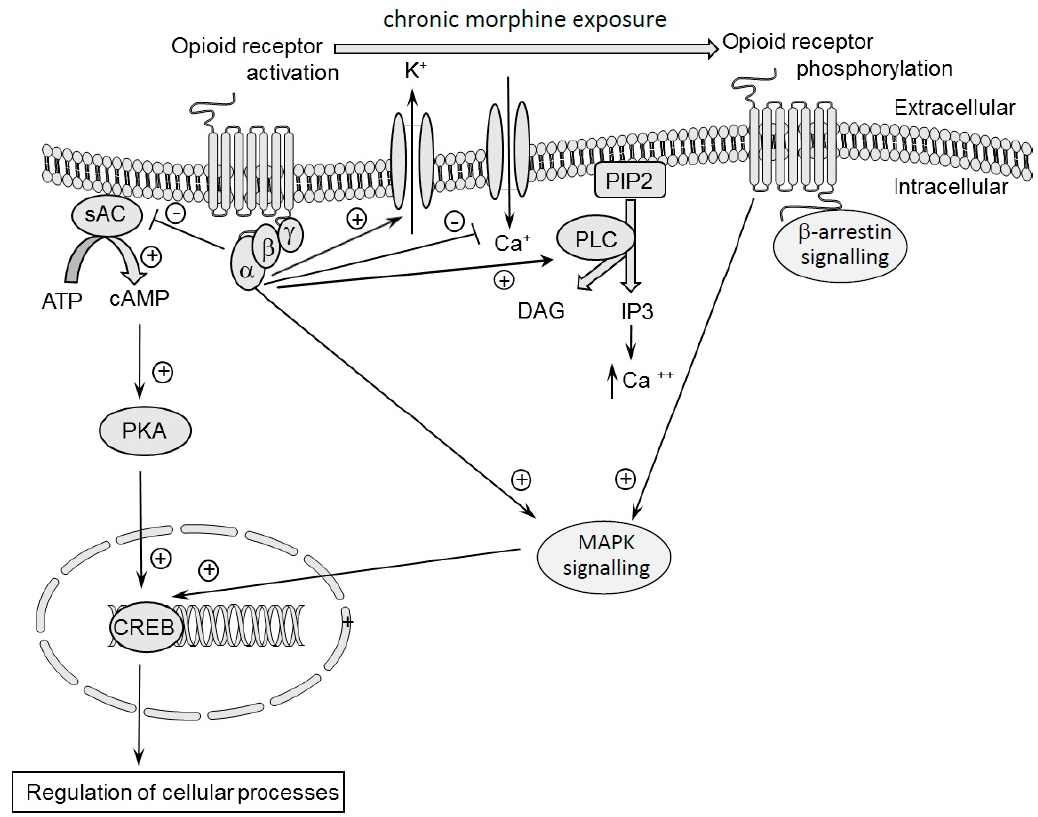
Figure 1. Molecular mechanisms of morphine action. A binding of ligand with an opioid receptor activates Go or Gi protein. G protein is composed of three subunits: α , β and γ . The ligand binding results in opioid receptor activation by GTP binding to the α subunit. The α -GTP complex dissociates from the dimer βγ -subunits. Both complexes: α -GTP and dimer βγ , participate in intracellular signal transduction. This leads to an inhibition of adenylate cyclase activity and reduction of cAMP level and protein kinase A inside the cell. The activation of potassium channel and cellular hyperpolarisation is observed. The βγ dimer blocks the calcium channel and reduces calcium concentration inside the cells. The chronic stimulation of opioid receptors by morphine induces the phosphorylation of opioid receptors. sAC–soluble adenylyl cyclase; PKA–protein kinase A; CREB–cAMP response element binding protein; PIP2–phosphatidylinositol biphosphate; PLC–phospholipase C; DAG–diacylglycerol; IP3–inositol triphosphate; MAPK–mitogen-activated protein kinases.